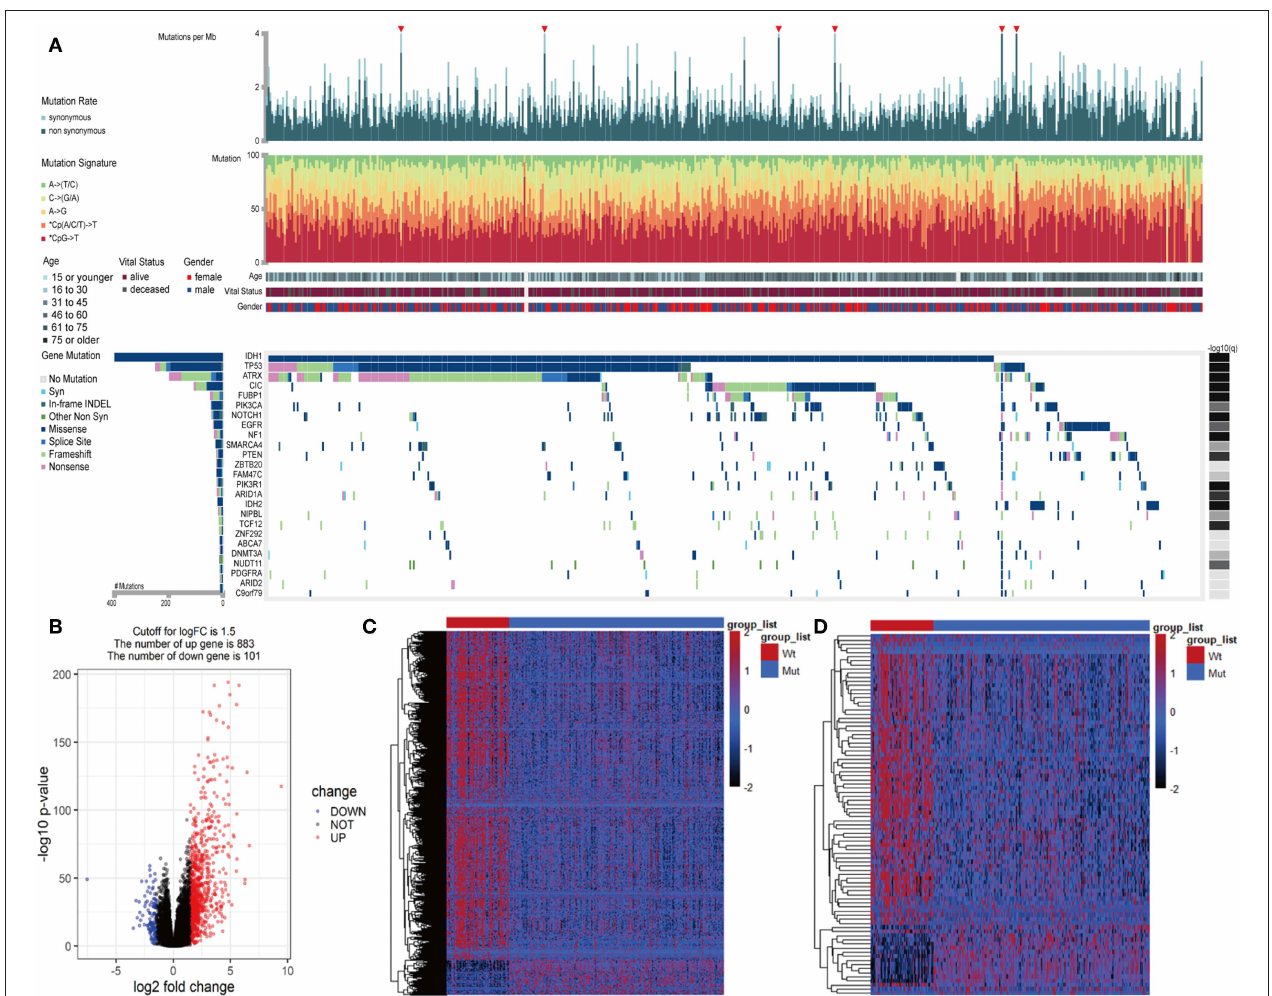
FIGURE 1 | Identified IDH1-associated immune genes. (A) Genomic landscape of LGG and the mutational signatures in the TCGA dataset, which were assayed on the FireBrowse platform. (B) Volcano plot of 984 genes differentially expressed between IDH1 wt and IDH1 mut patients. (C) Heatmap of genes differentially expressed between IDH1 wt and IDH1 mut patients. (D) Heatmap of immune genes differentially expressed between IDH1 wt and IDH1 mut patients.